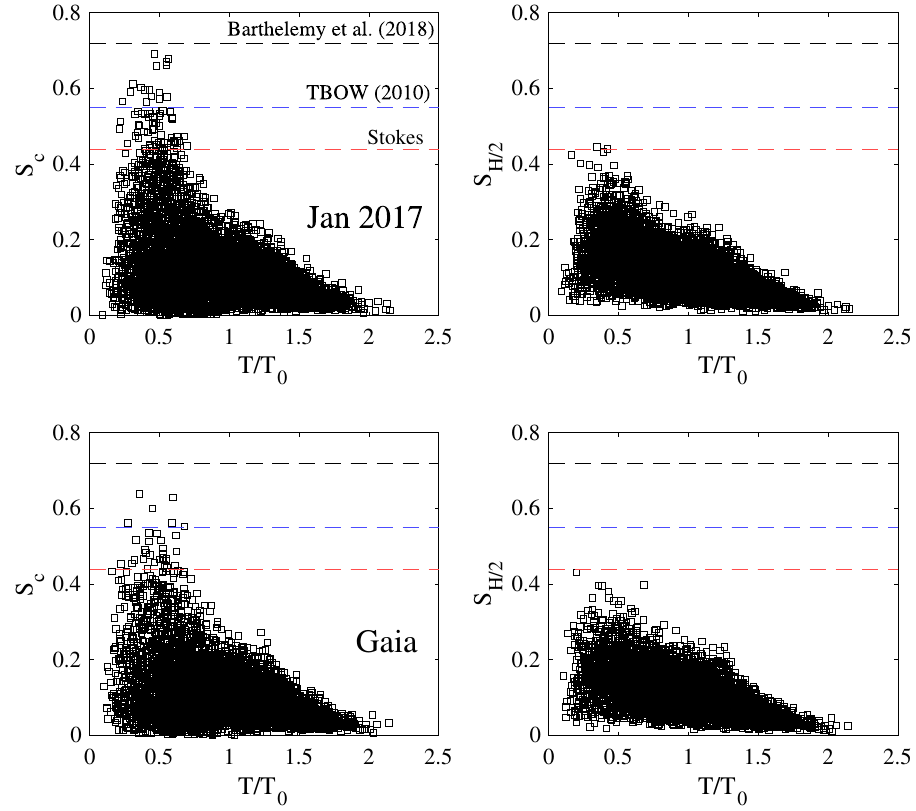
kh and S H / 2 kH / 2 versus local period T / T 0 for (top panels) Jan Figure 5. Observed Local steepnesses S c = = 2017 and (bottom panels) Gaia storms. Stokes limit = 0.448, TWBO limit 21 = 0.55 and Barthelemy et al. 22 = 0.72. k = local wave number, h = crest height, H = crest-to-trough height and T 0 = mean zero-crossing period. Because of the crest-trough asymmetry, on average h > H / 2 and S c > S H / 2